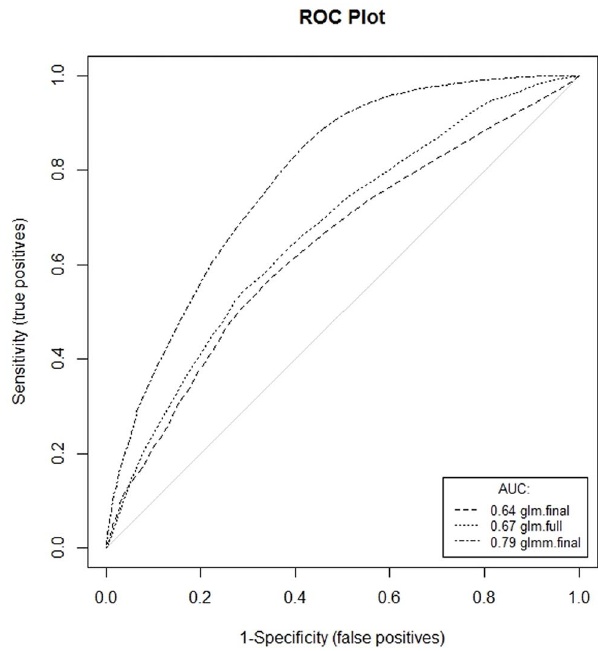
Figure 4. Comparison of the predictive performance of models by